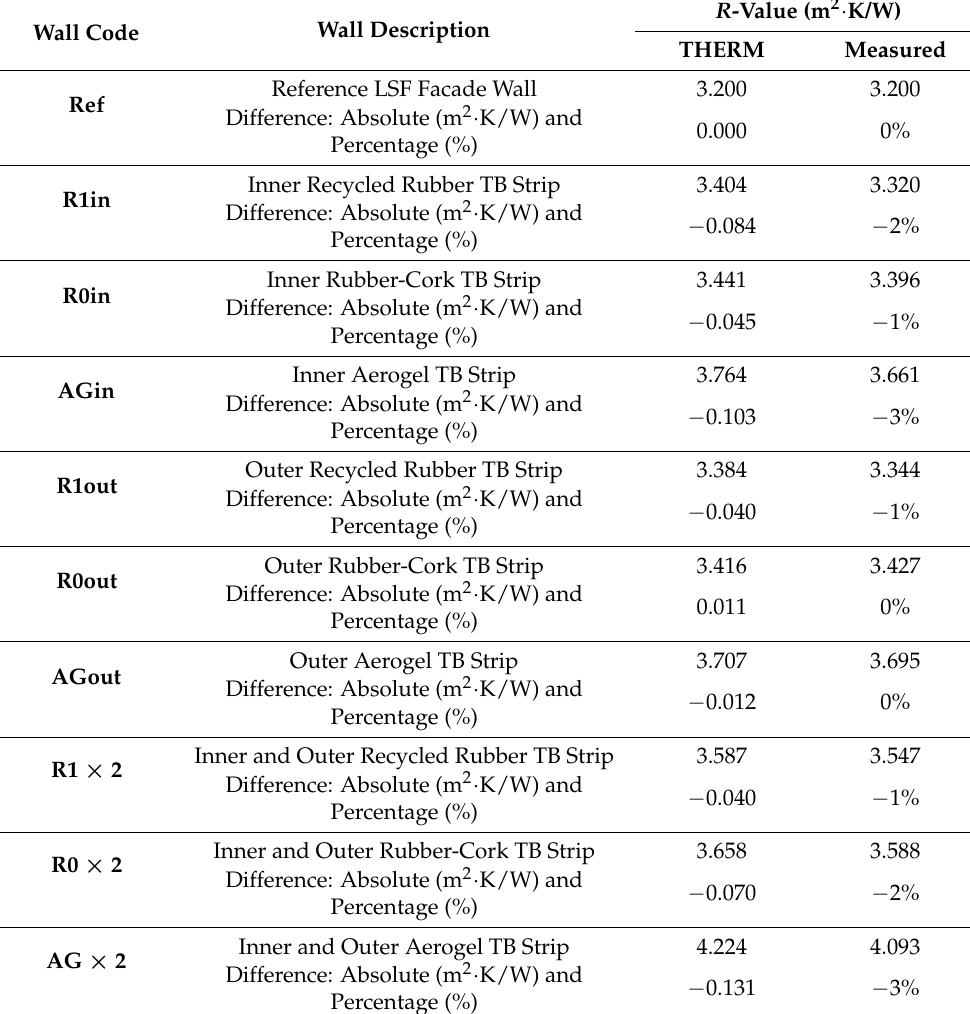
Table 3. Thermal resistances (surface-to-surface) predicted (THERM) and measured. Wall